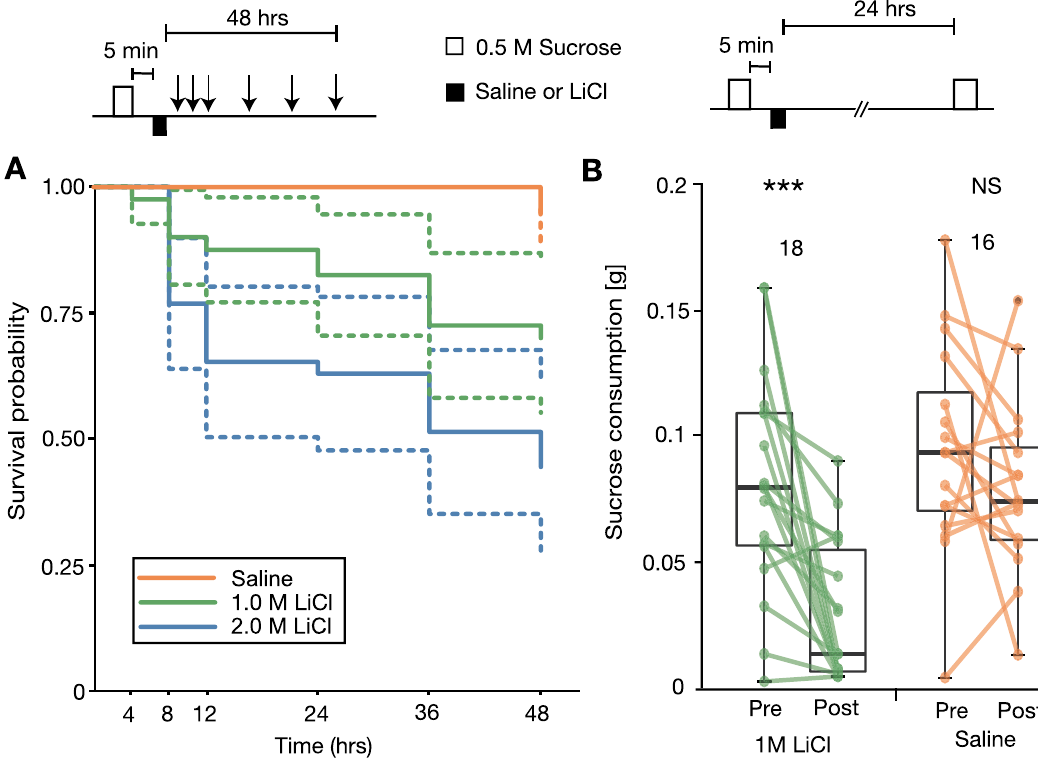
Figure 2. Effects of injections of different concentrations of LiCl solution paired with sucrose consumption. ( A ) Kaplan–Meier plots of survival probabilities of three groups of crickets that received injection of different concentrations of LiCl solution. Crickets in all groups were allowed to consume 0.5 M sucrose solution for 2.5 min and they were injected 5 min later with 5 µl of saline (n = 50) or saline containing 1 M LiCl (n = 50) or 2 M LiCl (n = 54) solution. The probability of survival was measured at various times up to 48 h after injection. Dashed lines indicate 95% confidence interval. The log-rank test was used to compare survival probabilities of different groups. ( B ) Two groups of crickets were allowed to consume 0.5 M sucrose solution for 2.5 min (pre- test) and they were injected 5 min later with 5 µl of saline or saline containing 1 M LiCl. Sucrose consumption was tested again for 2.5 min 1 day after injection (post-test). The Wilcoxon test was used for statistical comparisons of amounts of sucrose consumption before and after the CTA training (*** P < 0.001, ns: not